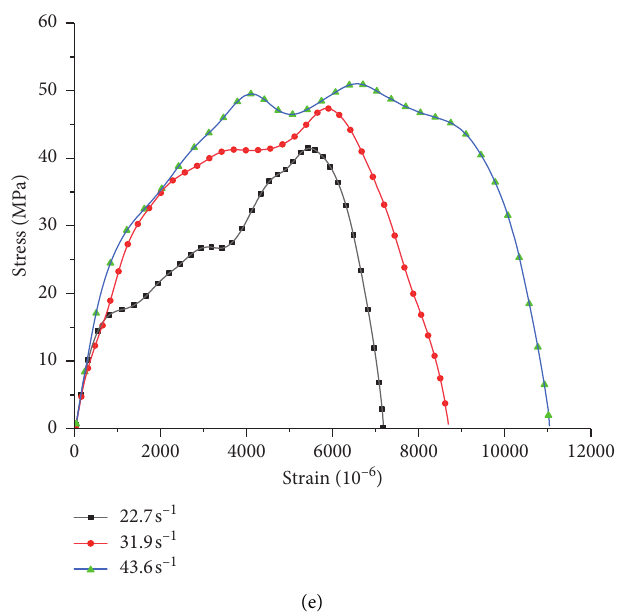
Figure 4: Impact stress-strain curves of different concretes: (a) NAC, (b) RAC30, (c) RAC100, (d) SRAC30, and (e) SRAC100. 1.051.101.151.201.251.301.351.401.451.50 F D I